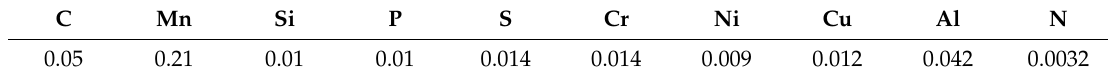
Table 2. Steel composition (wt%) used in the experiment